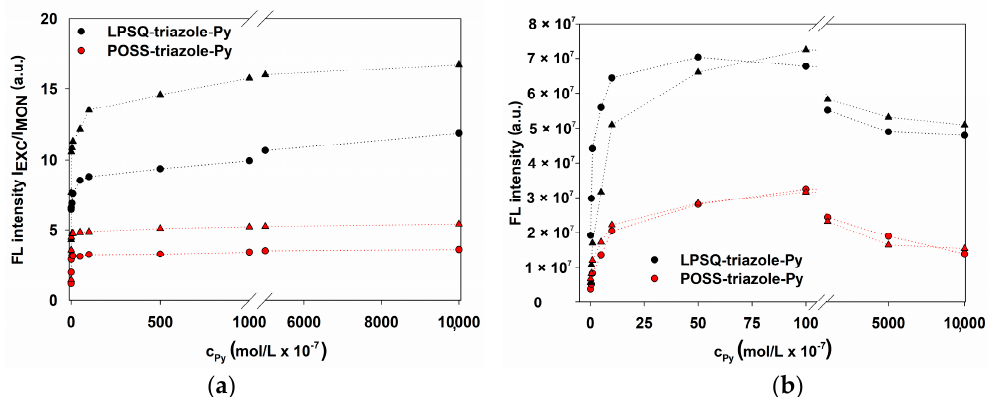
Figure 10. Comparison of fluorescence emission intensity ( a ) ratio I EXC / I MON and ( b ) I EXC as a function of pyrene groups concentration ( ● in THF, ▲ in CHCl 3 ; black for LPSQ, red for POSS).